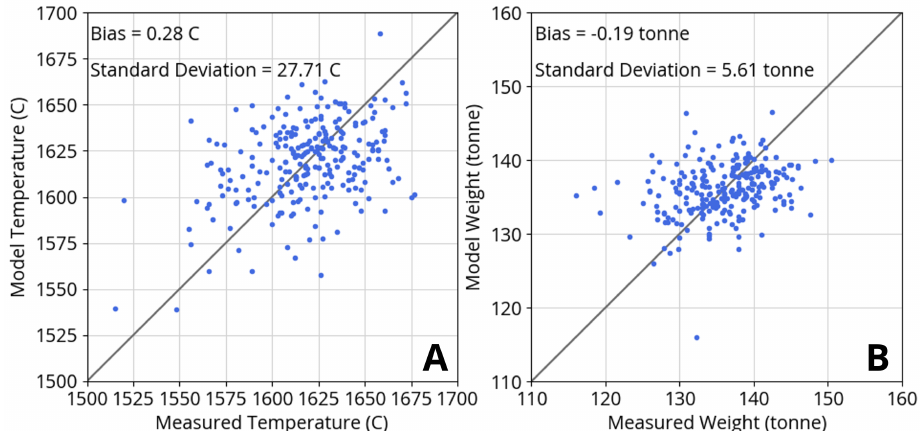
Figure 5. Agreement of model predictions with process measurements from 250 heats for ( A ) liquid steel temperature and ( B ) liquid steel weight after tapping. Model biases for temperature and weight are negligible while residual standard deviations reflect